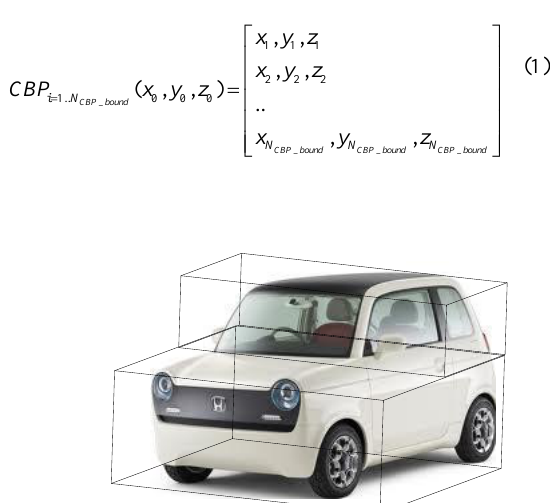
Figure 1. Car Modeling Using 3D Boxes